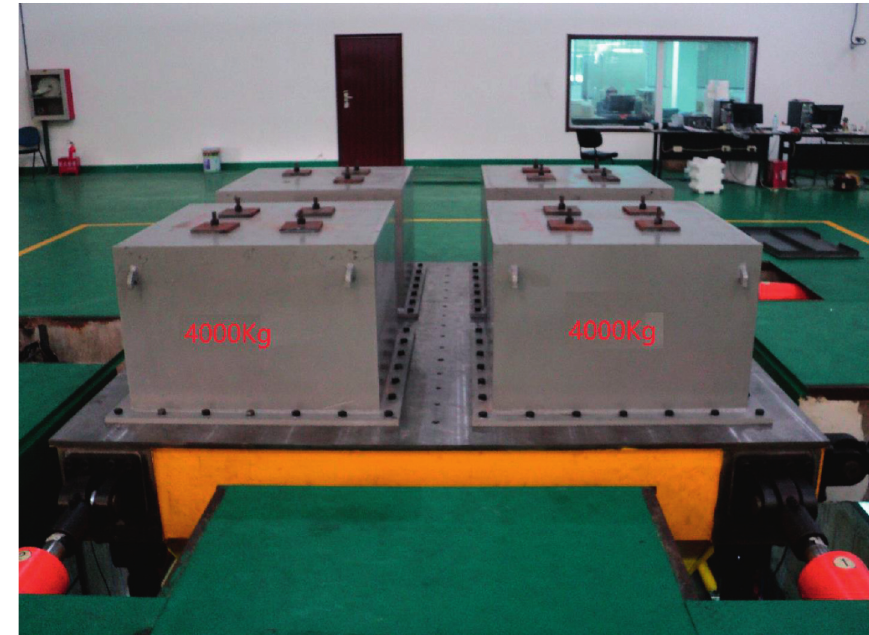
Figure 1: Multiaxis hydraulic servo shaking table experimental setup. Table 1: Main parameters of h multiaxis hydraulic servo shaking table. Parameters Motion table weight